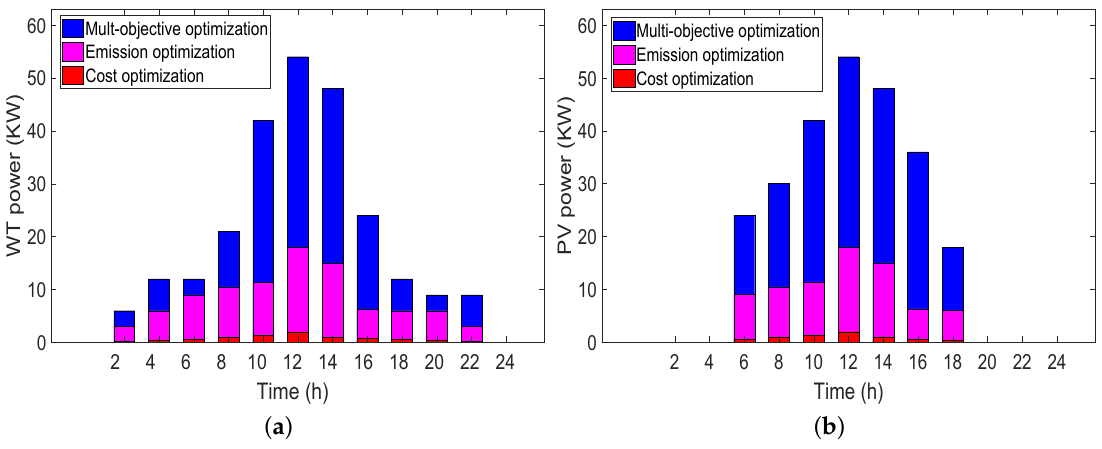
Figure 7. Renewable energy sources generation. ( a ) wind energy system; ( b ) solar energy system Figure 7a,b results show that maximum solar and wind energy production are utilized considering carbon emission and operation cost to establish a balance between them by simultaneous optimization. Table 1. Carbon emission optimization different energy generating units without